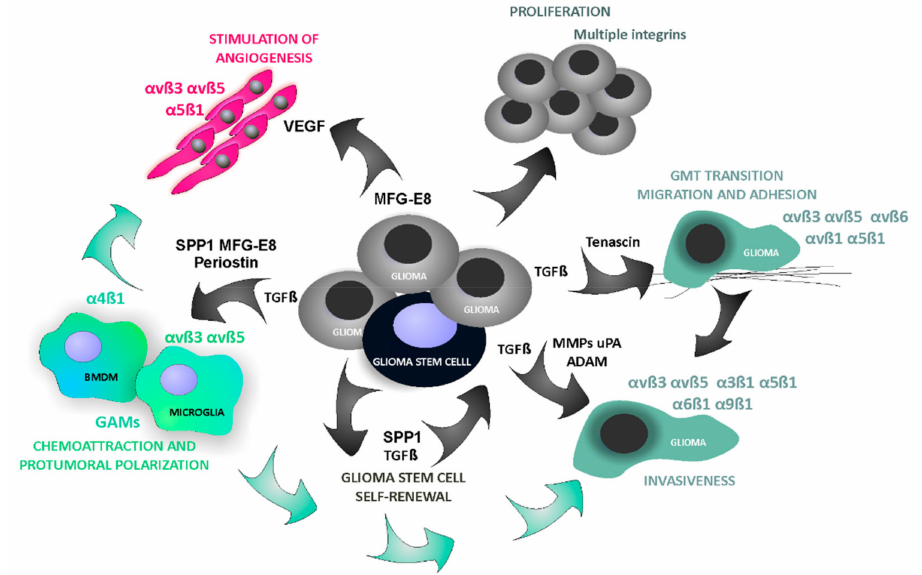
Figure 4. Role of integrins in glioma microenvironment. Abbreviations: GAMs, glioma-associated microglia and macrophages; GMT, glial to mesenchymal transition; MFG-E8, lactadherin; MMPs, metalloproteinases; SPP1, secreted phosphoprotein 1, osteopontin; TGF- β , transforming growth factor; VEGF, vascular endothelial growth